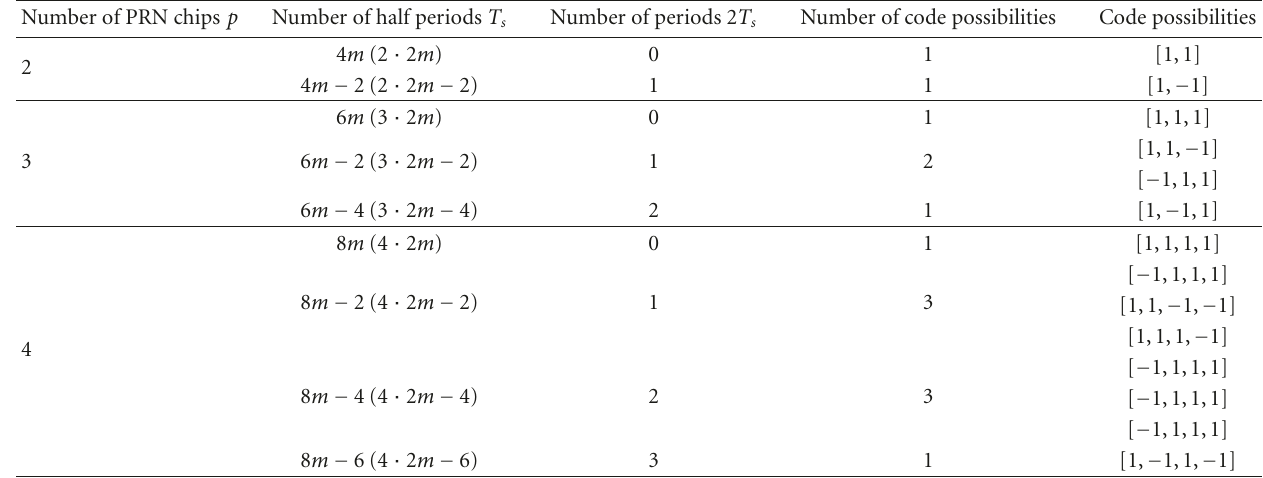
Table 1: BOC( m ,1) run length counts for all possible code subcarrier combinations. Number of PRN chips